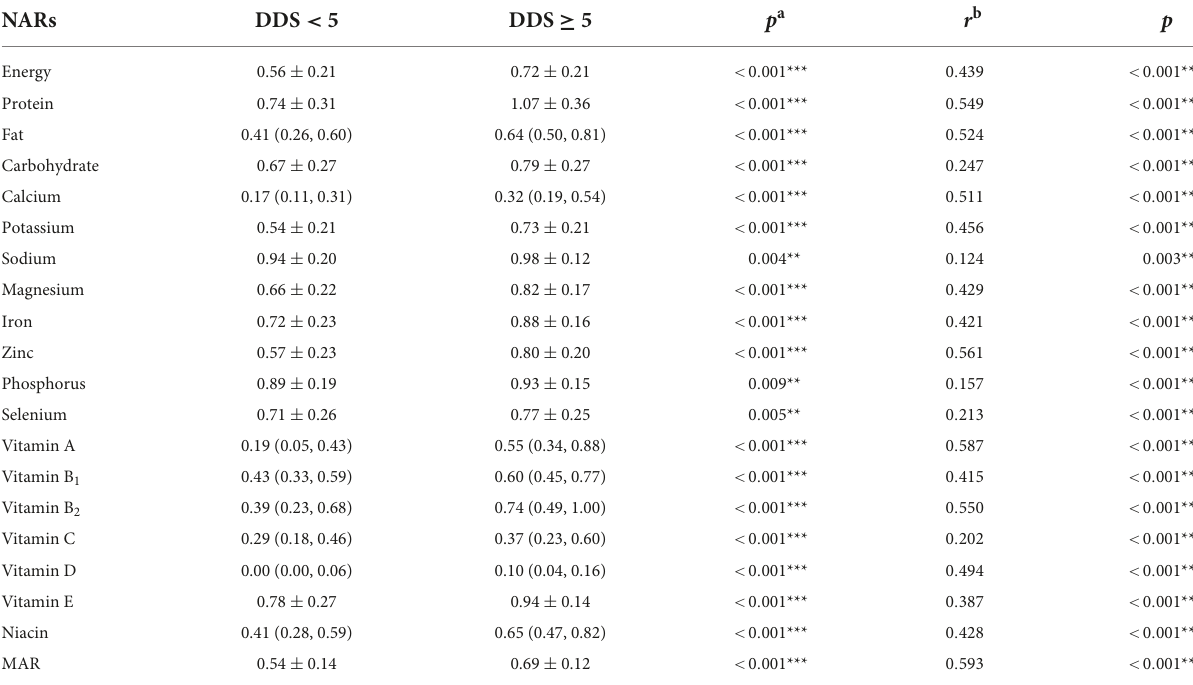
TABLE 3 NARs and MAR in low and high DDS